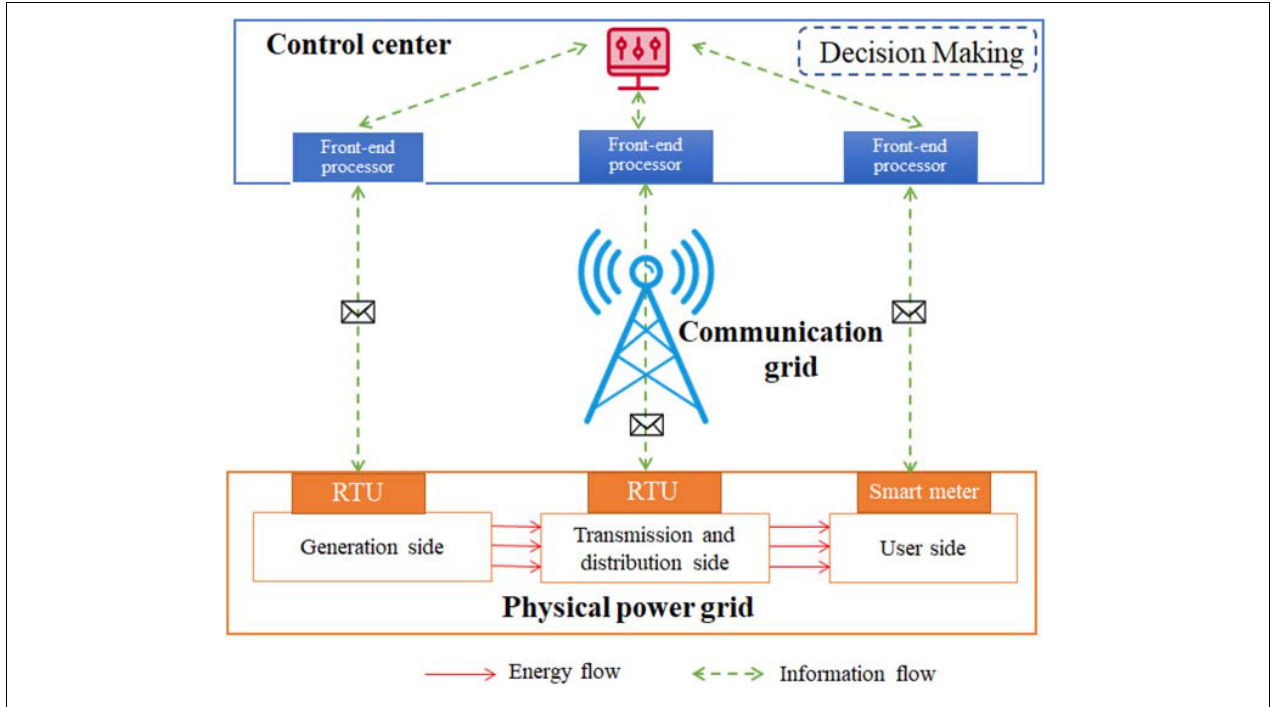
FIGURE 1 | Framework of